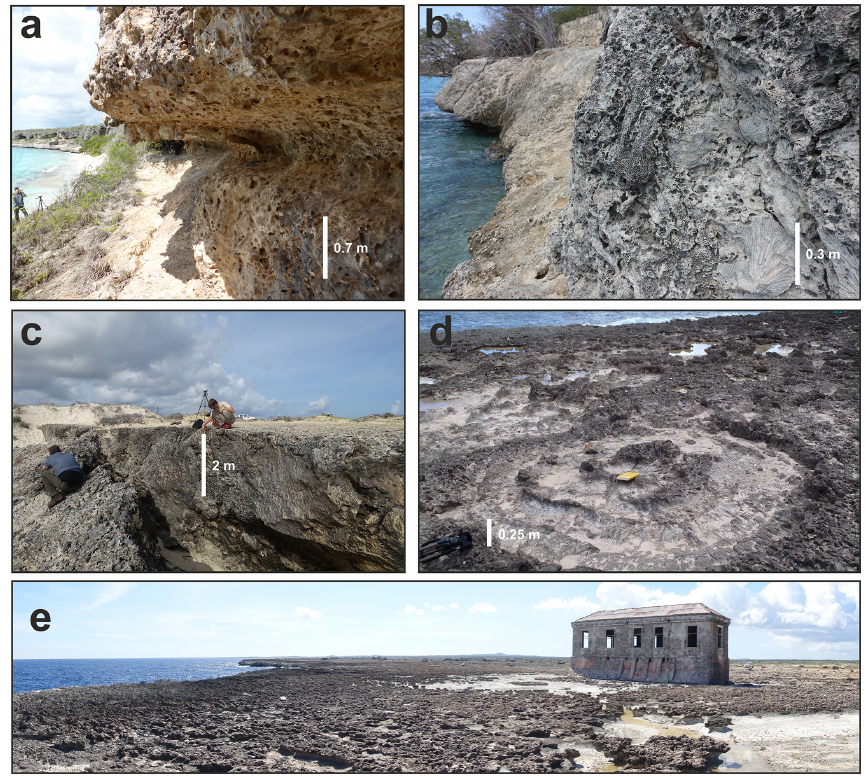
Figure 8. (a) Tidal notch on the leeward side of Bonaire; (b) last interglacial reef 1–2m below the location of the photo shown in (a) ; (c) exposed reef section on the windward side of Bonaire; (d) large massive coral eroded on top of the MIS 5e terrace on the windward side of Bonaire; (e) panorama view of the MIS 5e terrace on the windward side of Bonaire. Photos by Thomas Lorscheid (a) , Alessio Rovere (b, c, e) , and Thomas Felis (d)